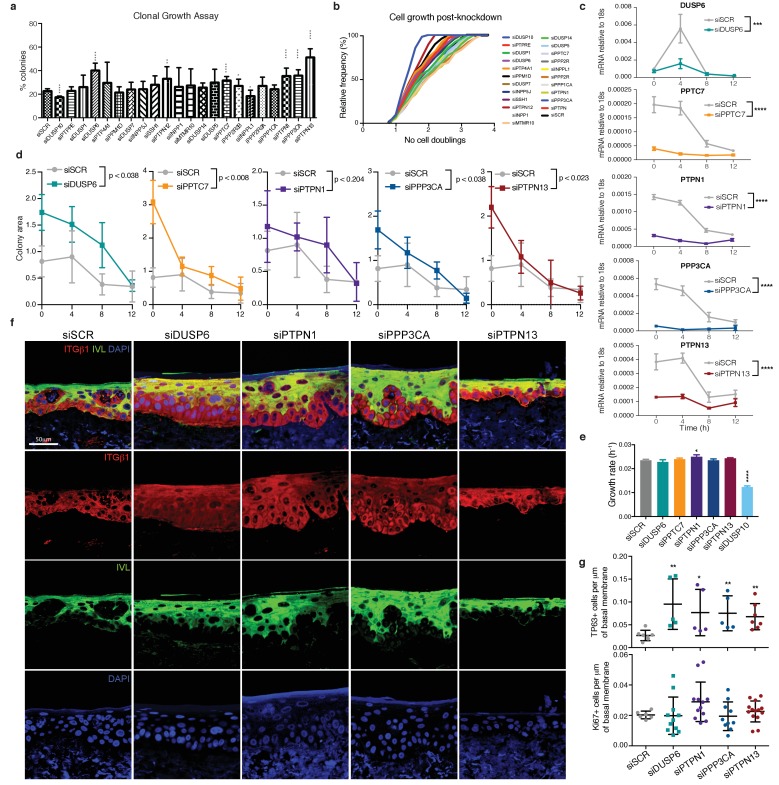
Effects of phosphatase knockdown on keratinocyte growth and differentiation.(a) Effect of phosphatase knockdown on colony formation. Values plotted are average % colony formation in three independent screens with three replicate dishes per screen. p-values were generated using a two tailedt-test. (b) Following siRNA transfection keratinocytes were seeded in collagen-coated 96-well format dishes and cultured in KSFM medium for three days. 24 hr post-transfection the culture dishes were moved into an Incucyte microscope and scanned every hour for the next 48 hr to evaluate cell growth and proliferation. Each data point is the average of three replicate screens with eight independent well scans per condition per screen. Values at each time point were normalised to the respective 0 hr time point or the first scan point. A cumulative plot is shown with the relative frequency (%) of cell doublings. (c) RT-qPCR quantification of phosphatases mRNA levels relative to 18 s RNA as a function of time in suspension, showing efficiency of the different knockdowns in the starting populations. p-values were generated by the unpaired T-test. (d) Kinetics of change in the total area occupied by colonies formed by cells recovered from suspension. (n = 3 independent samples). p-values generated by unpaired T-test. (e) Growth rate of human keratinocytes after phosphatase knockdown, calculated by fitting the data in (b) to an exponential growth curve and averaging the rates. p-values generated by one-way ANOVA (f) Sections of reconstituted epidermis from the experiments shown in Figure 2g labelled with antibodies to ITGβ1 and IVL, with DAPI as nuclear counterstain. Merge and individual channel images are depicted. Scale bar: 50 μm. (g) Quantification of the experiments shown in Figure 2g, showing the number of TP63+ (top panel) or Ki67+ cells (bottom panel) per μm of basement membrane. DAPI-labelled nuclei that were TP63+ were quantified in n = 2–3 fields per replicate. % Ki67+ nuclei were quantified in n = 3–6 fields per replicate. Error bars represent mean ± s.d. p-values were calculated using one-way ANOVA. a,c,d,g. Error bars represent s.d. *p<0.05; **p<0.01; ***p<0.0005; ****p<0.0001; ns = non significant.